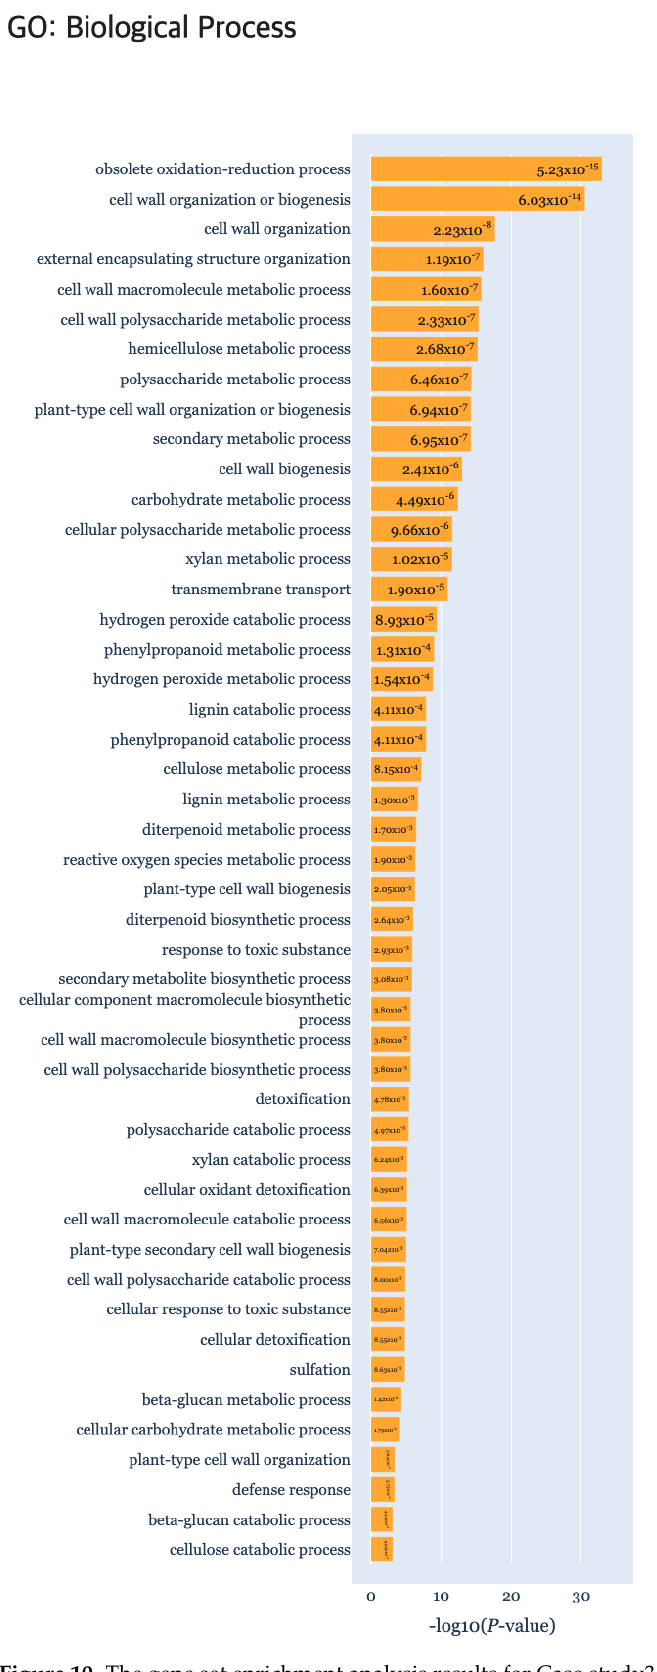
Figure 10. The gene set enrichment analysis results for Case study3 detecting significant GO: Biologi- cal Process using